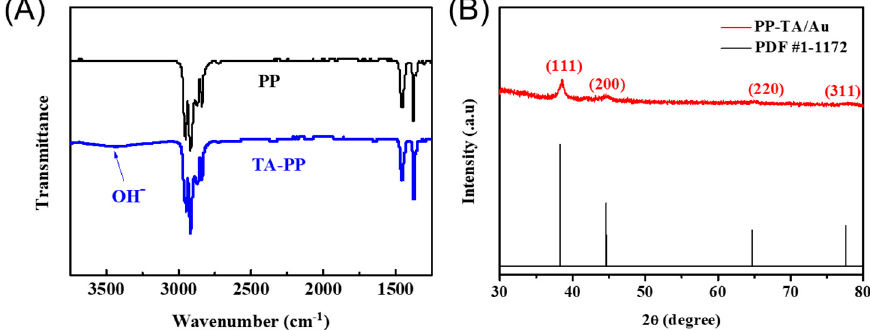
Figure 3. ( A ) FTIR spectra of pristine PP and PP-TA separator. ( B ) XRD spectra of PP-TA/Au separator.